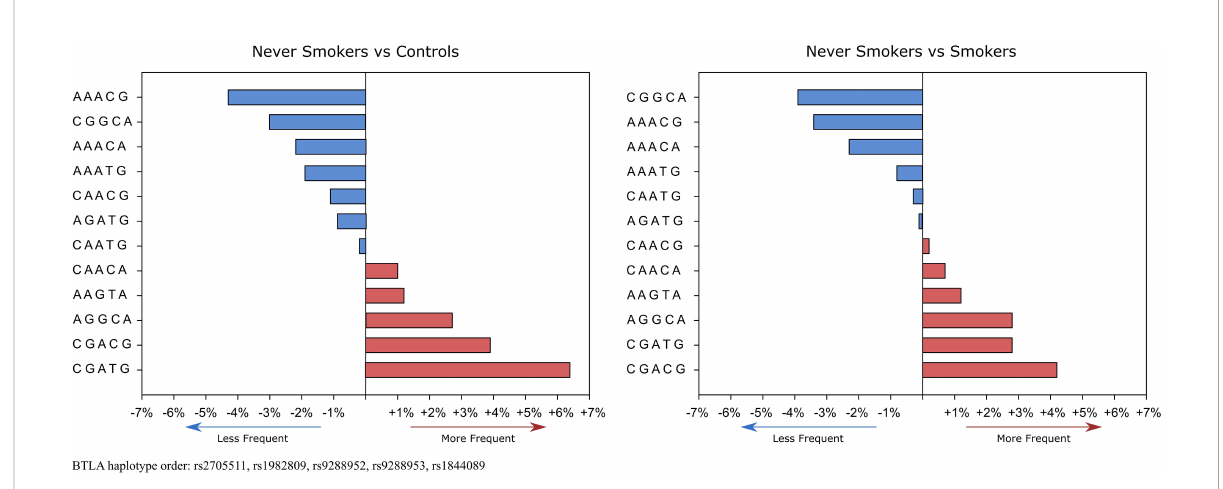
FIGURE 2 Haplotype ’ s frequencies distribution in never-smokers compared to controls and smokers. Red boxes show haplotypes that occur more frequently and blue boxes show haplotypes that occur less frequently in never-smokers. % values on the x-axis represent % differences in the occurrence of speci fi c